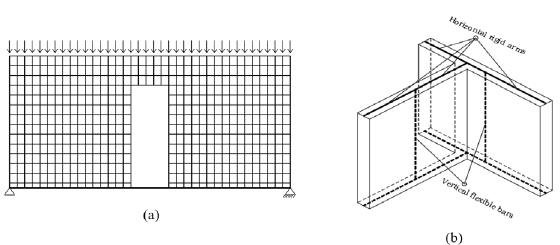
Figure 2. Numerical modeling: (a) Equivalent frame model (EqFM); (b) Three-dimensional frame model